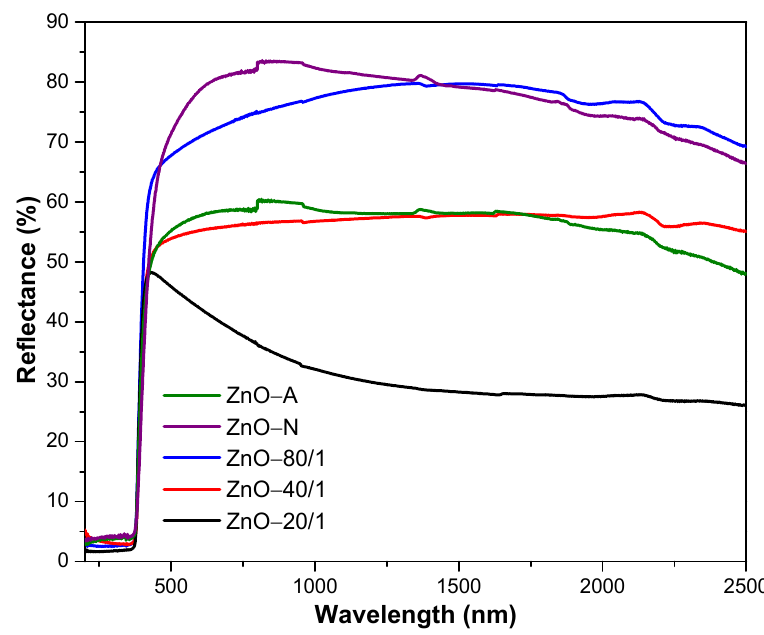
Figure 6. UV-Vis-NIR reflectance spectra of ZnO with different ratios of ZA/ZN precursors. Figure 6. UV ‐ Vis ‐ NIR reflectance spectra of ZnO with different ratios of ZA/ZN precursors.